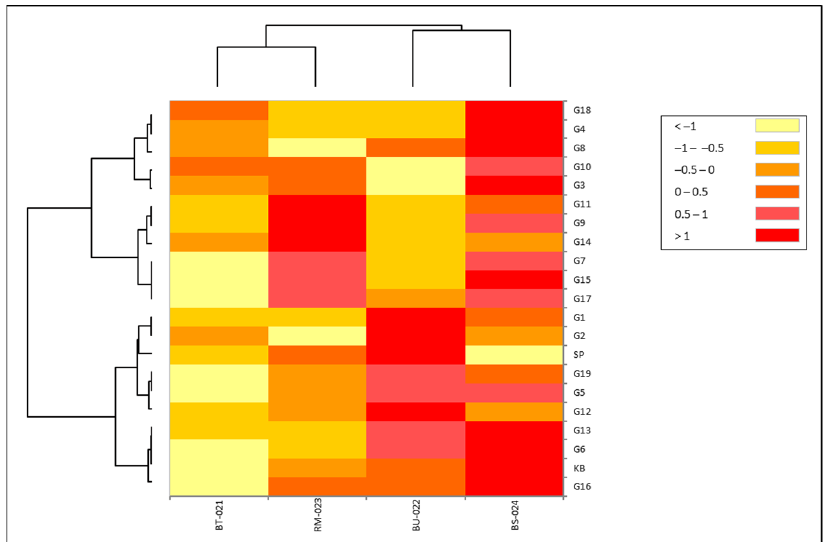
Figure 4. Heat map to show the virulence of isolates BT-021, BU-022, RM-023, and BS-024 based on severity level on 19 upland rice lines. High values are indicated in red and low values in yellow.